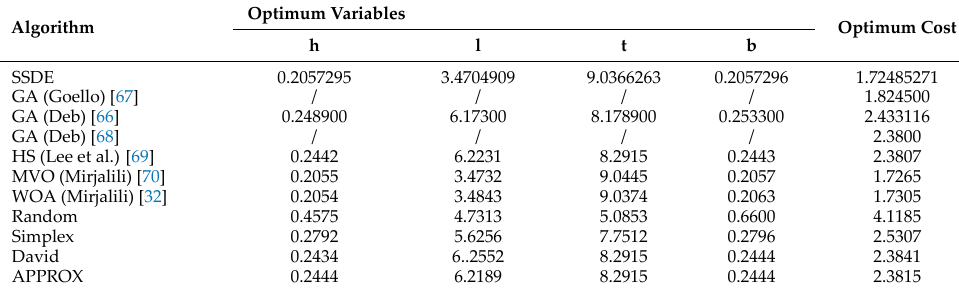
Table 6. Comparison of results of the welded beam design problem.